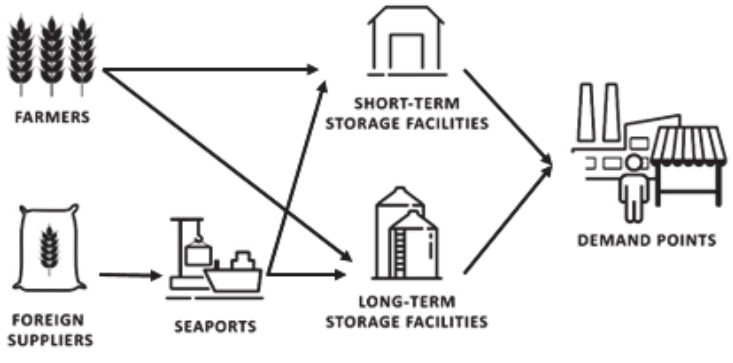
Fig. 1. The wheat supply chain considered in this paper